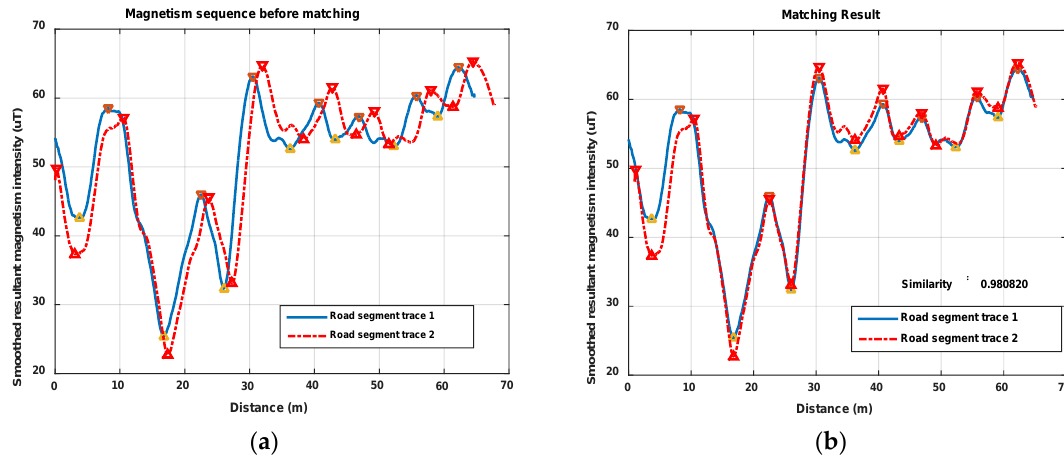
Figure 12. Magnetism matching and similarity calculation results for two traces generated on the same road segment: ( a ) smoothed magnetism sequences and detected features marked by the initial estimated distance; ( b ) magnetism sequences after feature matching and sequence zooming, and their calculated similarity.